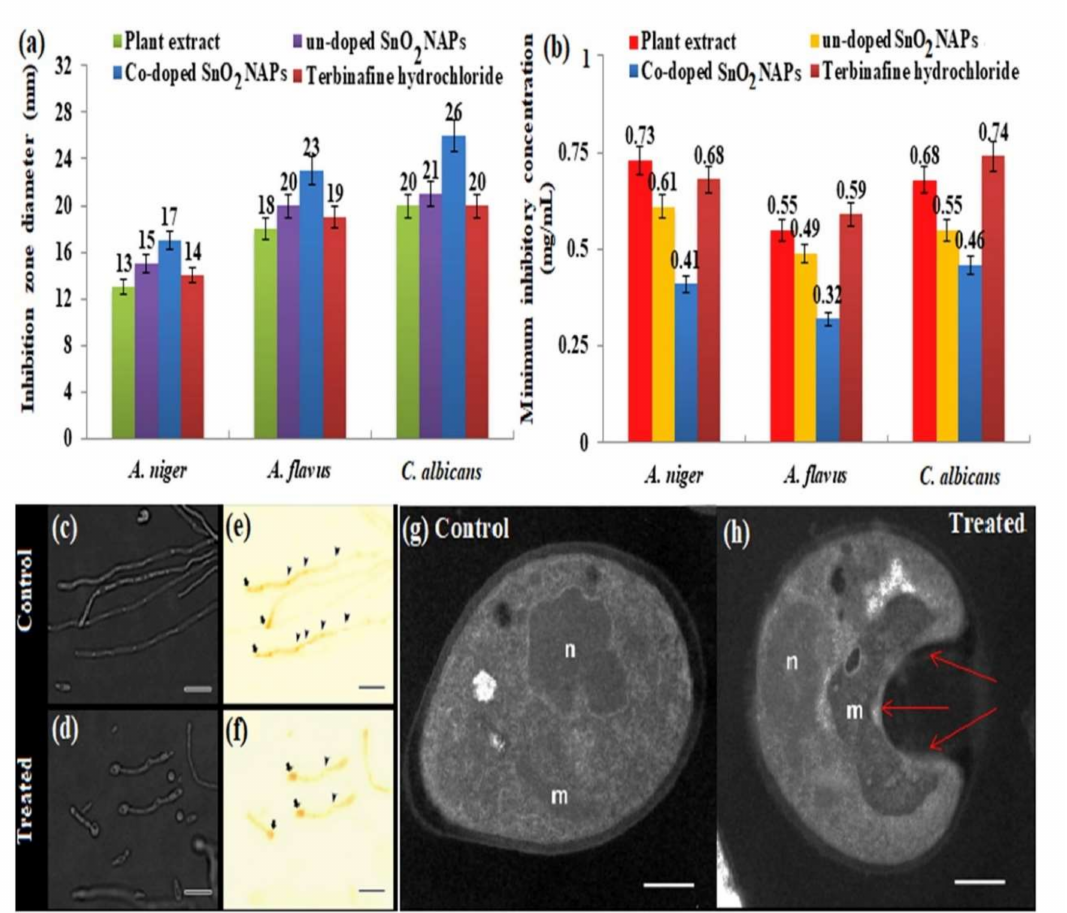
Figure 16. ( a ) ZOIs in antifungal test and ( b ) MIC test of plant extract, un-doped SnO 2 NAPs, Co- doped SnO 2 NPs and standard drug against fungal strains. Fluorescence microscopy with Calcofluor black shows the development of hyphae and pseudo-hyphae in controls ( c , e ) and Co-doped SnO 2 NPs treated cells ( d , f ). TEM image of untreated Candida albicans cells ( g ) and treated with Co-doped SnO 2 NPs ( h ) showing the changes detected in the cellular nucleus (n) and mitochondria (m). Figure reprinted from Reference [166]. Copyright 2018